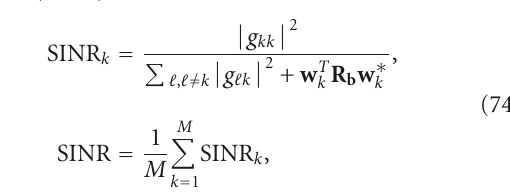
Table 1: Comparison of the algorithms complexity against weight